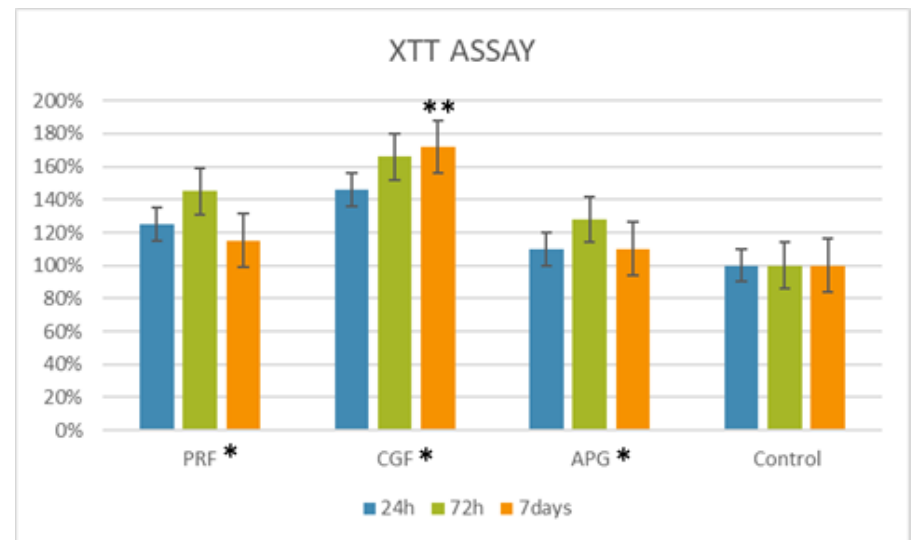
Figure 1. Graphical representation of the growth curve of the human periodontal ligament fibroblast (HPLF) cells in contact with the APCs at different times. For 24 h, the highest peak is registered for the PRF, followed by the CGF and APG. At 72 h and at 7 days, the material with best performance is the CGF, followed by the PRF and APG. The two-way ANOVA shows how the biomaterial proliferation values were statistically significant (*) with a p-value < 0.05 compared to the control. Among the materials, the Dunnett’s multiple comparison test showed how the mean of the proliferation with CGF vs. control was statistically significant at 7 days (**).